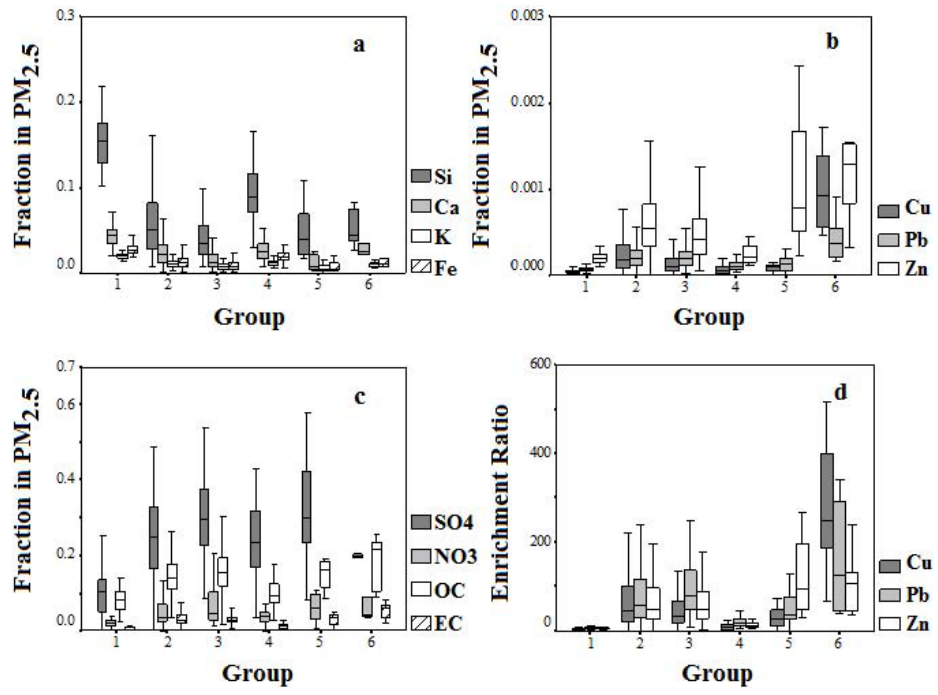
Fig. 4. Physical and chemical characteristics of aerosol samples in different clusters as generated by the hierarchical cluster analysis of all IMPROVE observation data from 2000 to 2007 at the GUMO1 site (continued): (a) mass fractions of Si, Ca, K, and Fe in in PM 2 . 5 ; (b) mass fractions of Cu, Zn, and Pb in PM 2 . 5 ; (c) mass fractions of Sulfate, Nitrate, OC and EC in PM 2 . 5 ; (d) enrichment factors of Cu, Zn and Pb using Si as the reference element between different groups classified by cluster analysis. The bottom and top edges of the box indicates the 25th and 75th percentile and the line in the box indicates the 50%. Group 1 was identified as the local dust